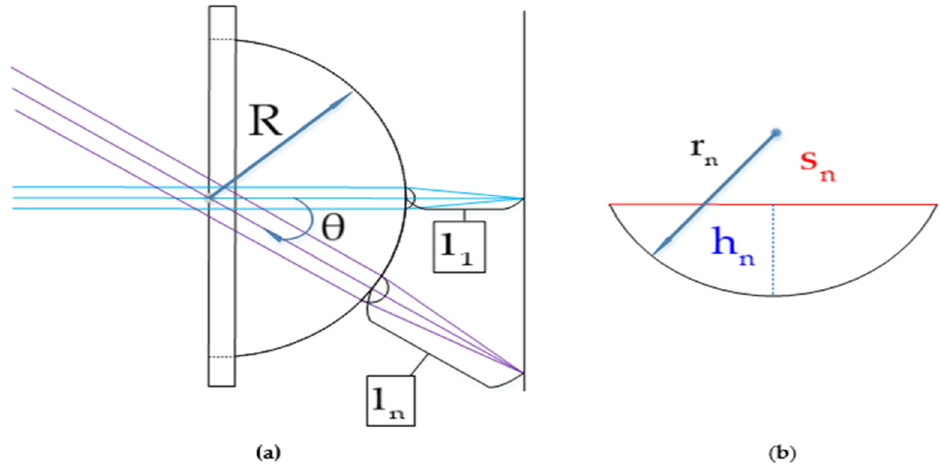
Figure 3. Schematic view of the multi-focusing compound eye. ( a ) Description of the design of the lens; ( b ) the parameters of the single ommatidium.